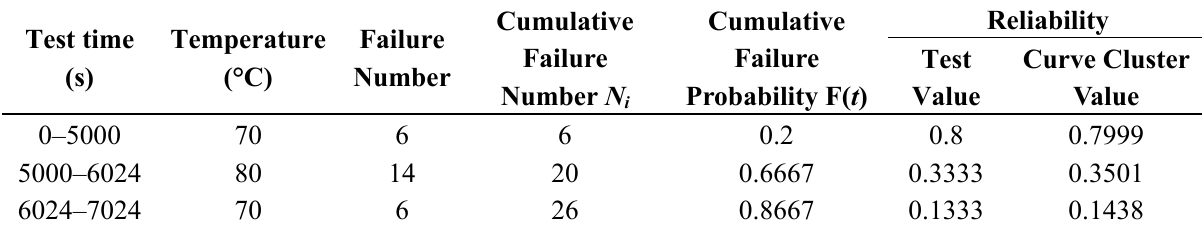
Table 3. Experimental verification test data of reliability evaluation method of oil–paper